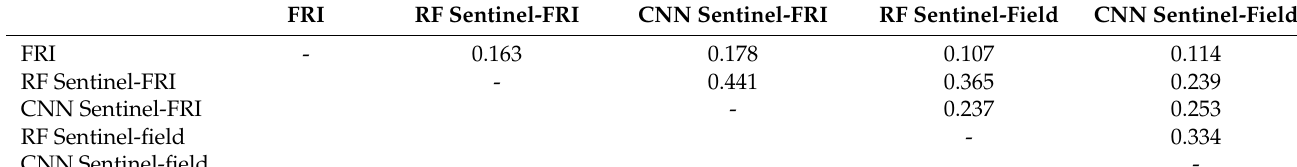
Table 4. Average species-specific coefficients of determination (R 2 ) between the FRI and model predictions of percent species composition for the Depot Lake region in Haliburton Forest, Ontario. The 3634-ha study site was subdivided into 40 by 60 m plots; see Table 3 for descriptions of the various predictions.